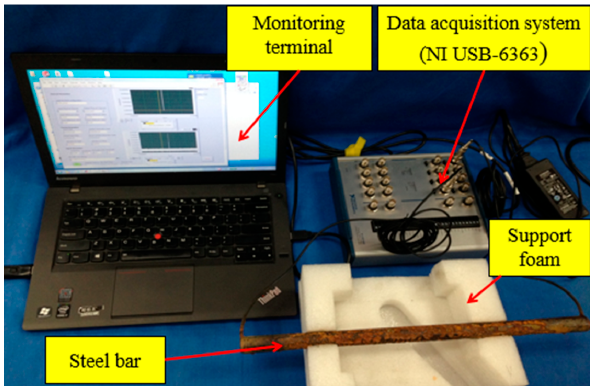
Figure 7. Experimental setup consisting of piezoceramic transducers to detect the corrosion of steel bar.